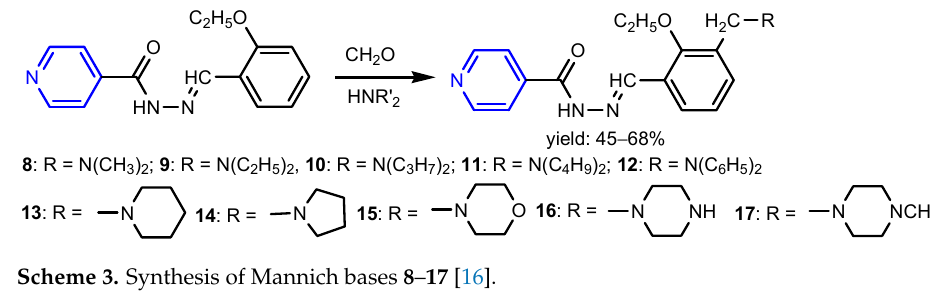
Scheme 3. Synthesis of Mannich bases 8 − 17 [16].